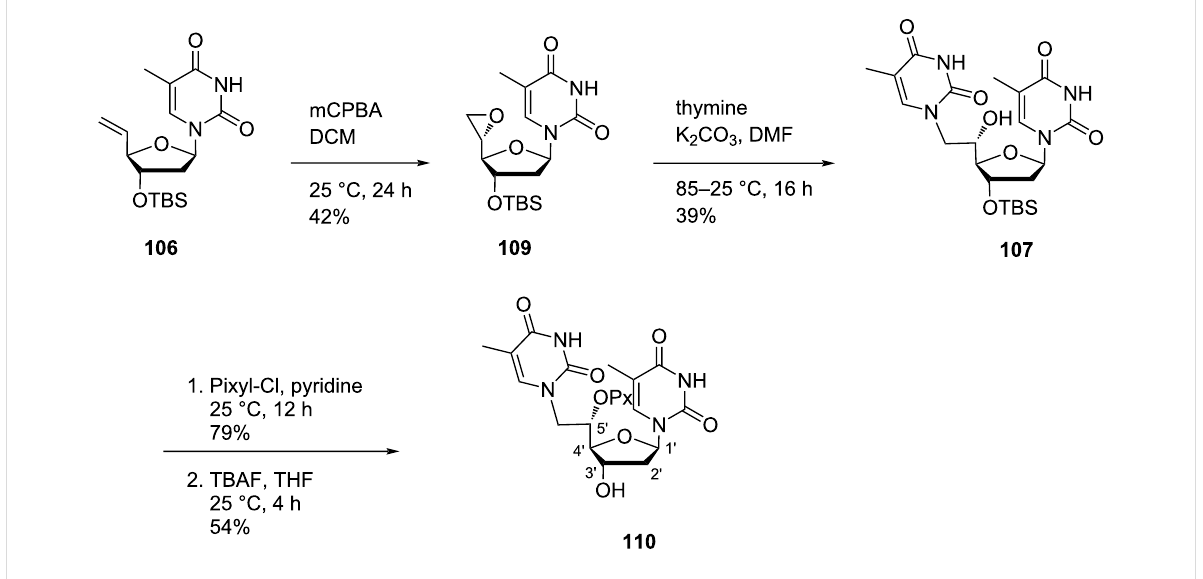
Scheme 25: Synthesis of double-headed nucleoside 110 with additional nucleobase in 5 ′ -( S )- C -position joined through methylene linker.